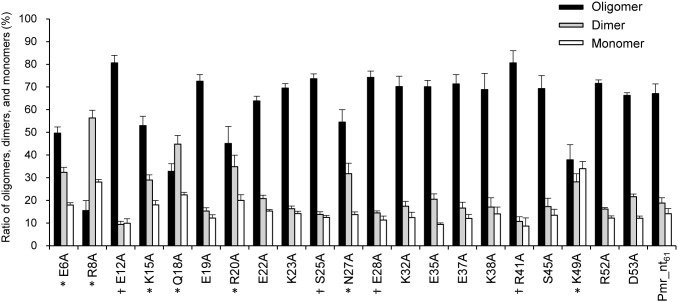
Ratio of oligomers, dimers, and monomers of Pmr_nt61 and its variants.After protein–protein cross-linking, samples were analyzed by Tricine-SDS-PAGE, and the intensity of the bands in the 60-min lane was quantified using the ImageJ software (http://rsbweb.nih.gov/ij/). Pmr_nt61 variants are indicated, such as “E6A” for Pmr_nt61-E6A. Data are expressed as means ± standard deviation from three (for Pmr_nt61 variants) or five (for native Pmr_nt61) independent experiments. Black, gray, and white bars show the percentages of oligomers, dimers, and monomers, respectively. * and † indicate Pmr_nt61 variants that had significant decreases and increases, respectively, in the ratio of oligomers compared with native Pmr_nt61 (P<0.05, two-tailed Student’s t-test).